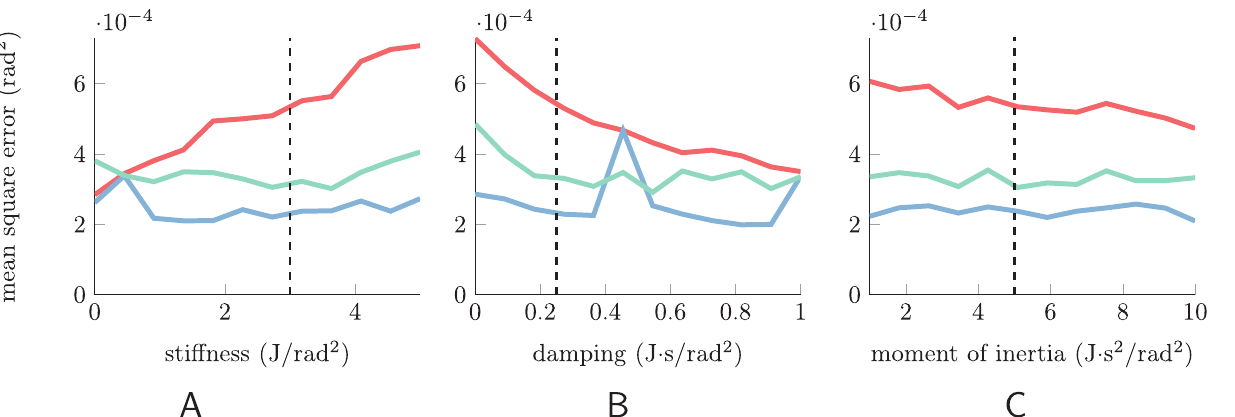
Fig 2. Mean squared errors (MSEs) for various dynamical systems. To show the flexibility of the rEFH, we train one for each of several different second- order dynamical systems. Each subplot shows the results for twelve different systems in which a single parameter has been varied across a range of values; otherwise the systems are identical to the undriven model of Fig 1. For each of those twelve dynamical systems, 20 rEFHs were trained (each with 150 hidden units), MSEs calculated, and the best selected (turquoise). The same was then done for EM 1 (light red) and EM 2 (blue), i.e., Kalman filters trained with EM, assuming either first- or second-order dynamics. The vertical black line in each plot indicates the dynamical system used in Fig 1 in the main text. (A) Varying the spring constant. The leftmost datum ( k = 0) corresponds to the “ no-spring ” model from which the RFs are analyzed below (although with lower transition noise); at this point, the dynamics can be well approximated by a first-order model. (B) Varying the damping coefficient. The spike in EM 2 at c = 0.4545 indicates that EM failed to find the second-order solution in any of its 20 attempts. As c increases and the systems approach critical damping, however, first-order approximations are increasingly adequate. (C) Varying the moment of